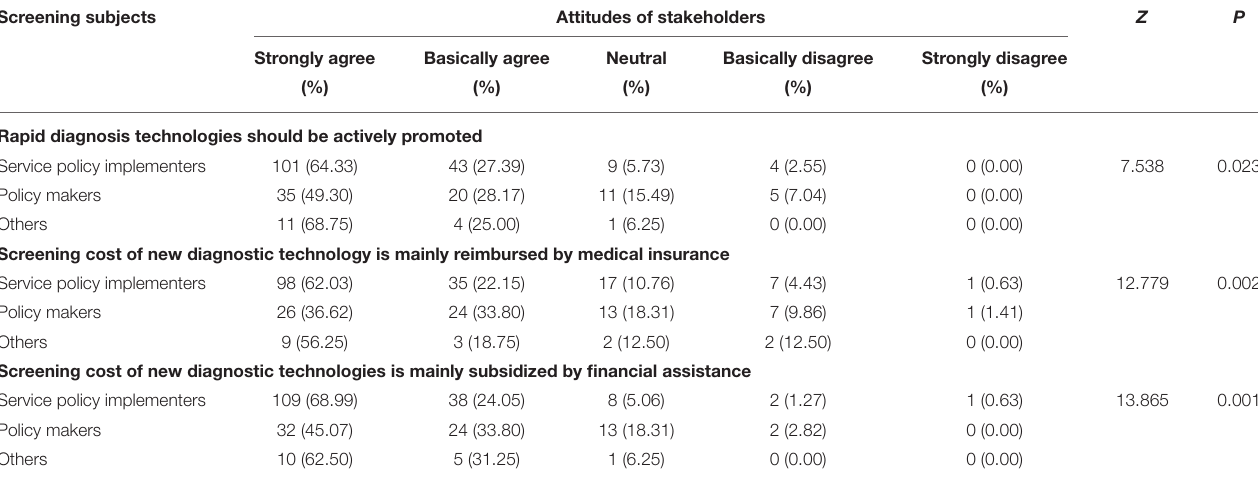
TABLE 7 | Attitudes of different categories of stakeholders among service providers toward the application of RR-TB rapid diagnostic technology strategy. Screening subjects